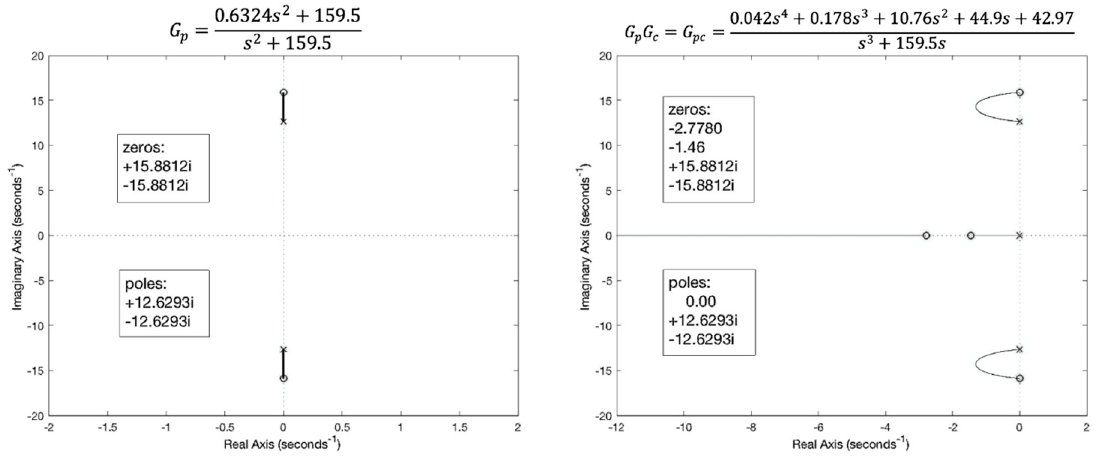
Figure 14. Root locus plots of the plant gain G p to the ( left ) and the plant-compensator gain G pc to the ( right ).